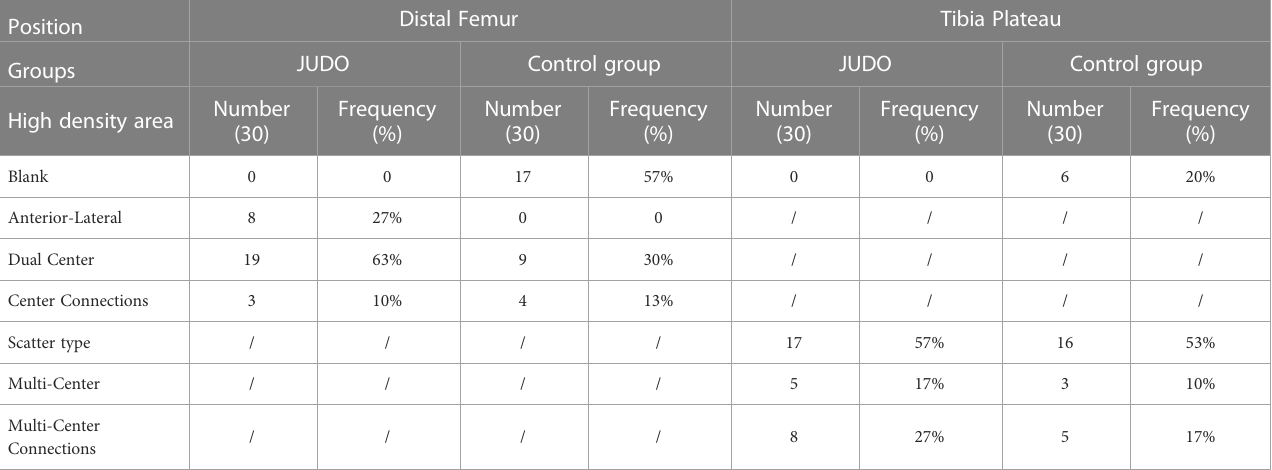
TABLE 3 knee articular distribution pattern of high bone density area classi fi cation data.